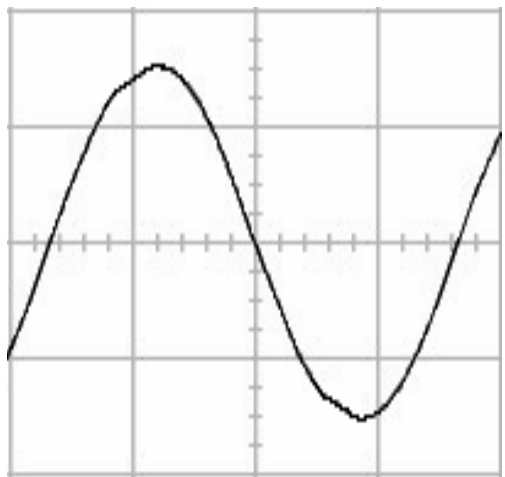
Figure 19. Experimental AC output voltage for the proposed method under rectifier load (vertical: 100 V/div and 5 ms/div). Table 2. Simulated AC output voltage total harmonic distortion